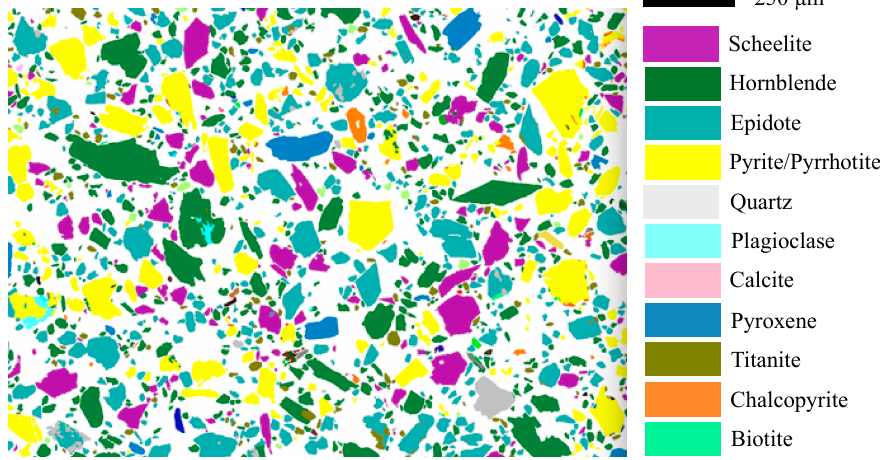
Figure 3. Mineral liberation analysis image showing the characteristics of minerals.